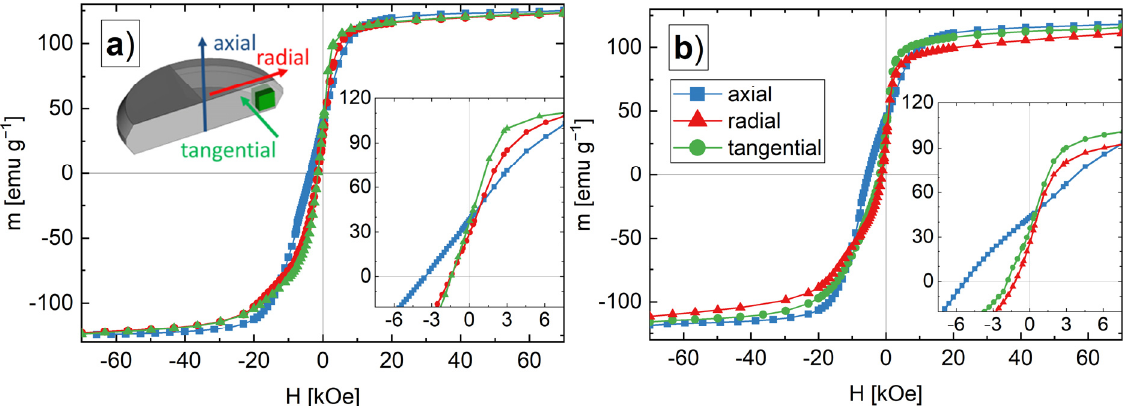
Figure 5. Demagnetizing curves starting from +70 kOe for the ball-milled and HPT-deformed powder (BM + HPT3) samples ( a ) and un-milled and HPT-deformed powder (HPT3) samples ( b ). The schematic illustration in ( a ) visualizes the measurement directions in respect of the different HPT-disc directions (axial: blue; radial: red; tangential: green). The insets show the demagnetizing branches in more detail.